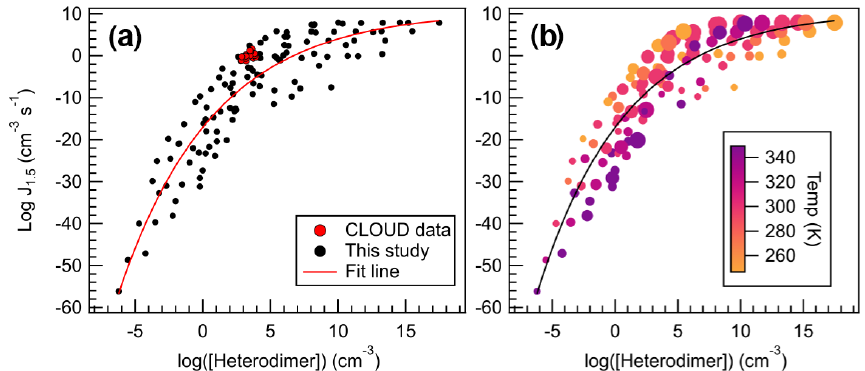
Figure 11. Heterodimer concentration plotted against J 4 × 4 for all calculated conditions for all sulfuric acid salts, wherein (a) all data are represented with black dots, and (b) data points are colored according to temperature and sized to reflect monomer concentrations (10 5 – 10 9 cm − 3 ). Data were fitted to an exponential function, which can be found in the Supplement and Eq. (4).